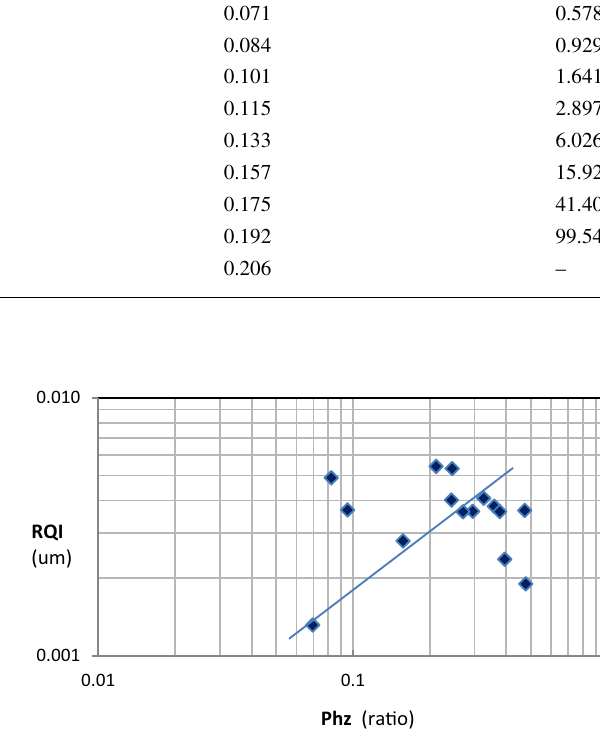
Fig. 2 A plot of log permeability versus porosity